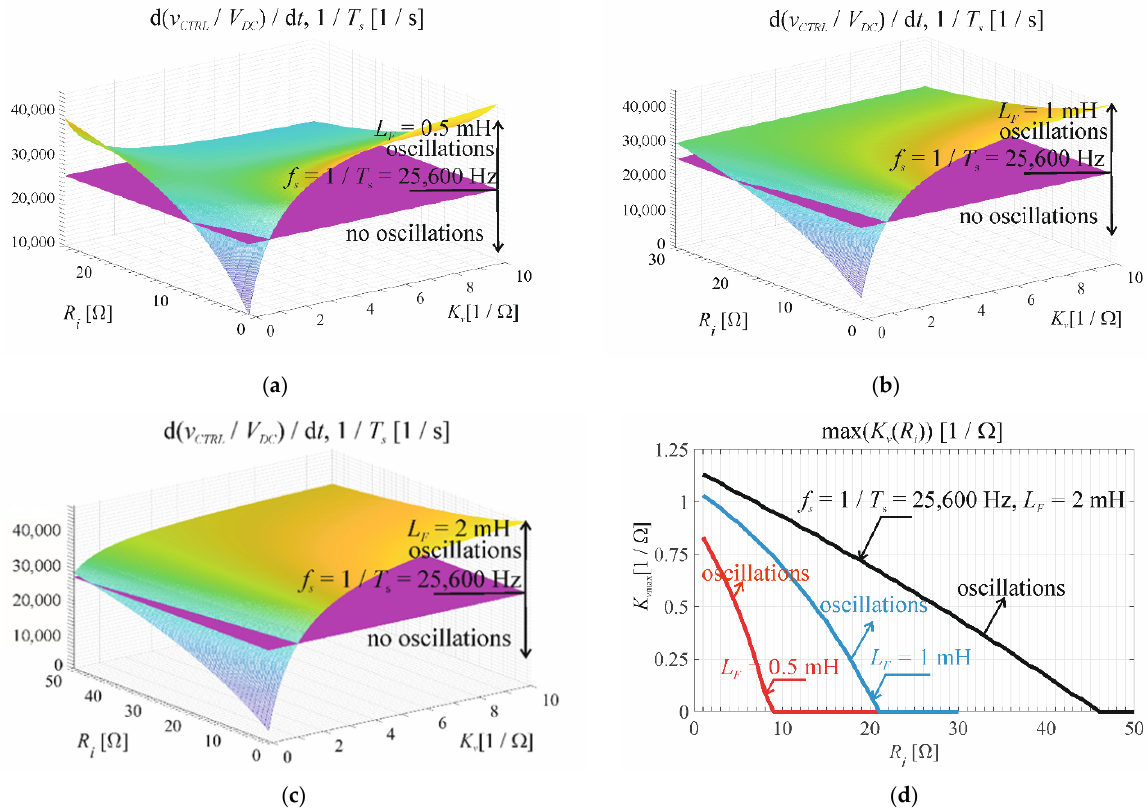
Figure 2. Determining the border gains ( d ) of the IPBC controller for different switching frequencies (12,800 ( a ), 25,600 ( b ), and 51,200 Hz ( c )) when L F = 1 mH, C F = 50 μ F, R LF = 1 Ω , and M = 0.5. The border values of the IPBC gains depended on the parameters of the output filter.